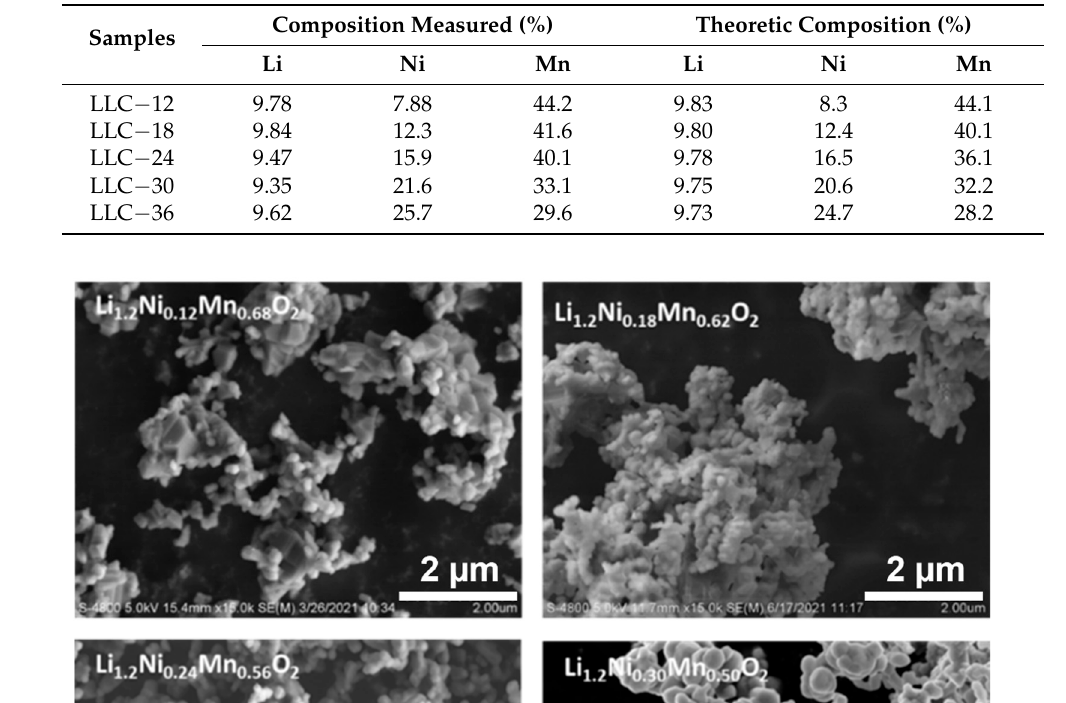
Table 2. Composition of Li, Ni and Mn for the as-prepared samples.